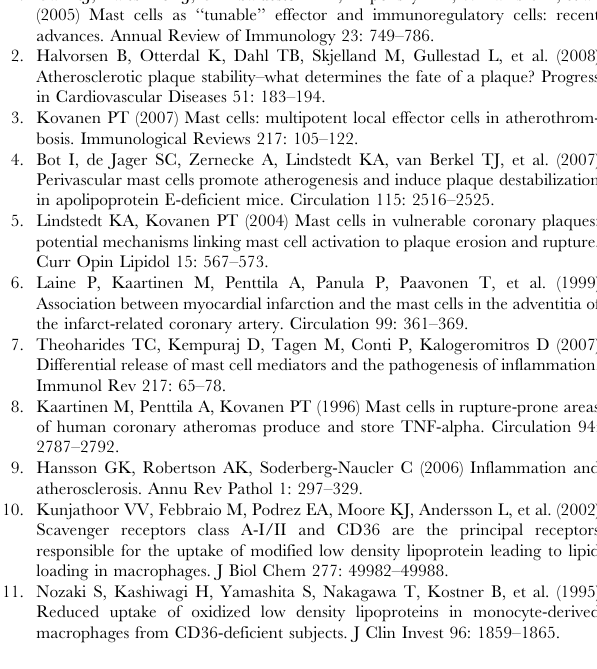
measured. Mean expression compared to non-treated cells (n= 3) and SEM are presented. (TIF) Figure S2 Effect on macrophage LOX-1 expression of selected mediators contained in mast cell releasate. Monocyte-derived macrophages were incubated with A) tryptase, B) heparin, or C) interferon gamma for 4 h and 24 h, and analyzed for LOX-1 mRNA expression (n= 4 donors). The results are presented as means 6 SEM. All statistical comparisons were non-significant. Table S1 Reagents used in this study. Table S2 qPCR primers and probes (5 9 –3 9 orientation). Table S3 mRNA expression (arbitrary unit*) of hista- mine receptors 1 and 2 in human monocytes and macrophages from 3 donors. File S1 Detailed methods for quantitative PCR and western blot